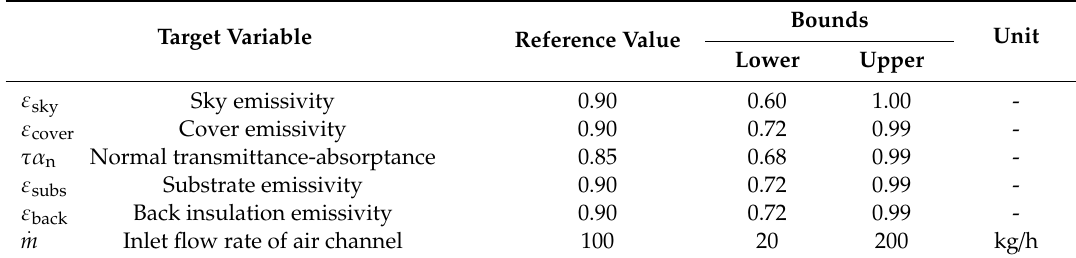
Table 3. The target variables and values for sensitivity